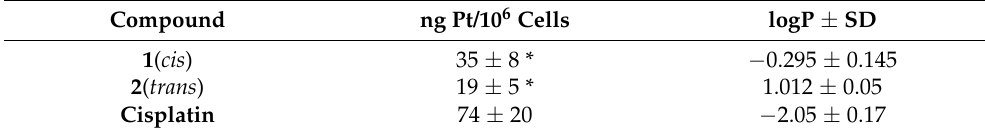
Table 1. Total cellular platinum uptake in MCF-7 Cells (±SD) and experimentally measured logP ± SD (n = 4) values.